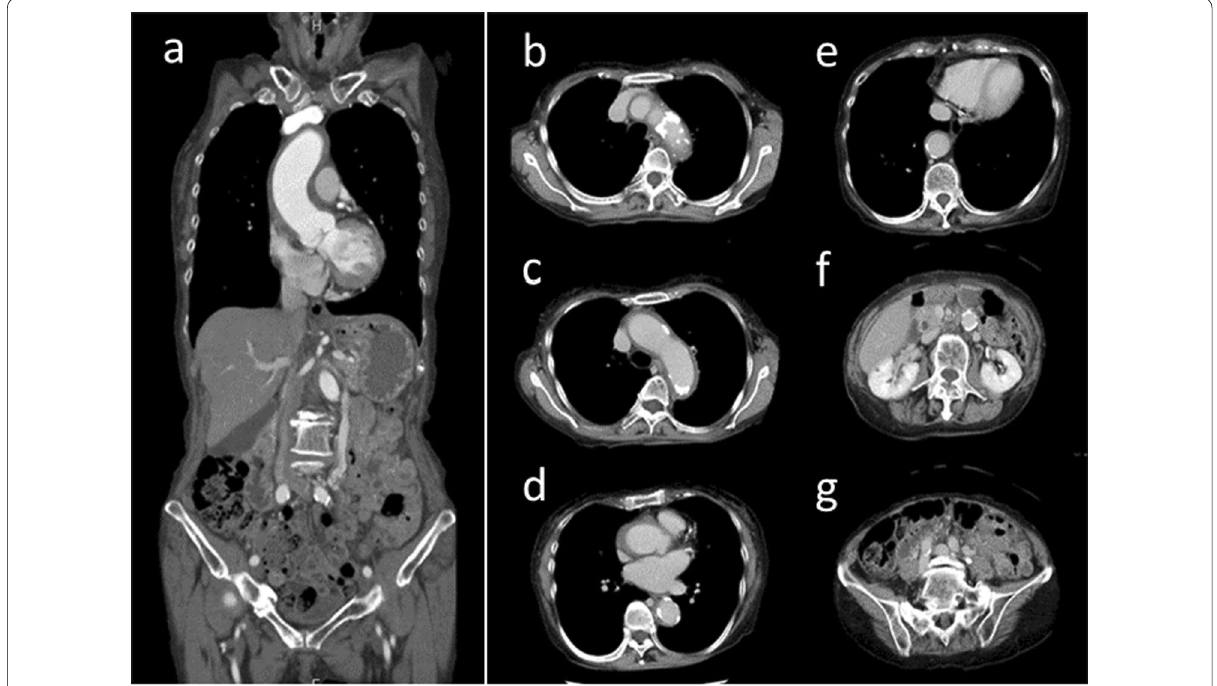
Fig. 1 Computed tomography imaging of acute type A aortic dissection. a Dissected ascending aorta. The maximum short diameter of the ascending aorta was 39 mm, and the maximum thickness of the thrombosed false lumen was 4 mm. b, c Dissected aortic arch. d Dissected aortic root and descending aorta of left atrial level. e Dissected descending aorta. f Non-dissected infrarenal aorta. g Non-dissected iliac